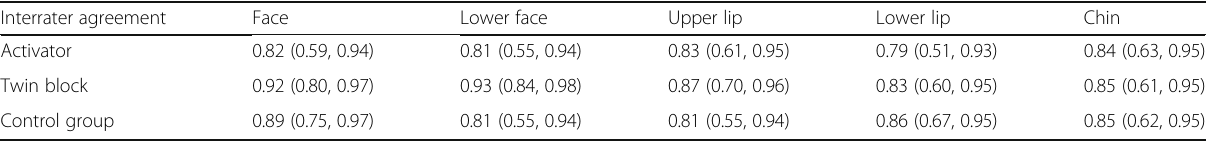
Table 4 Interrater agreement of VAS ratings among groups of raters for the three treatment groups, tested through the intraclass correlation coefficient (ICC; two-way mixed model, absolute agreement, results regarding average measures) Interrater